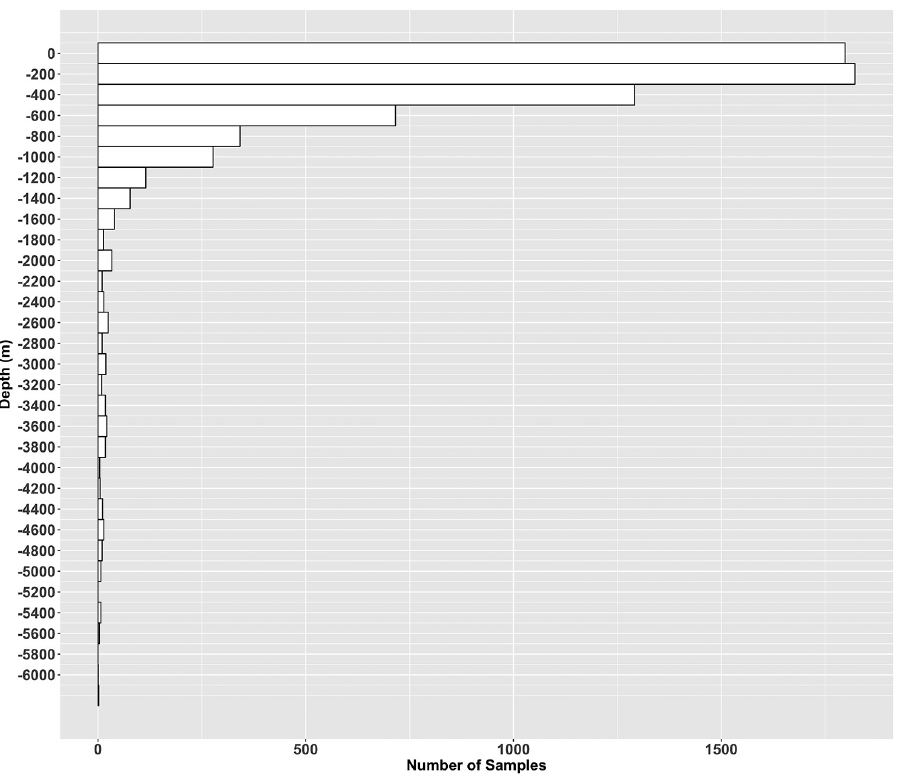
Figure 4. Number of occurrences according to depth